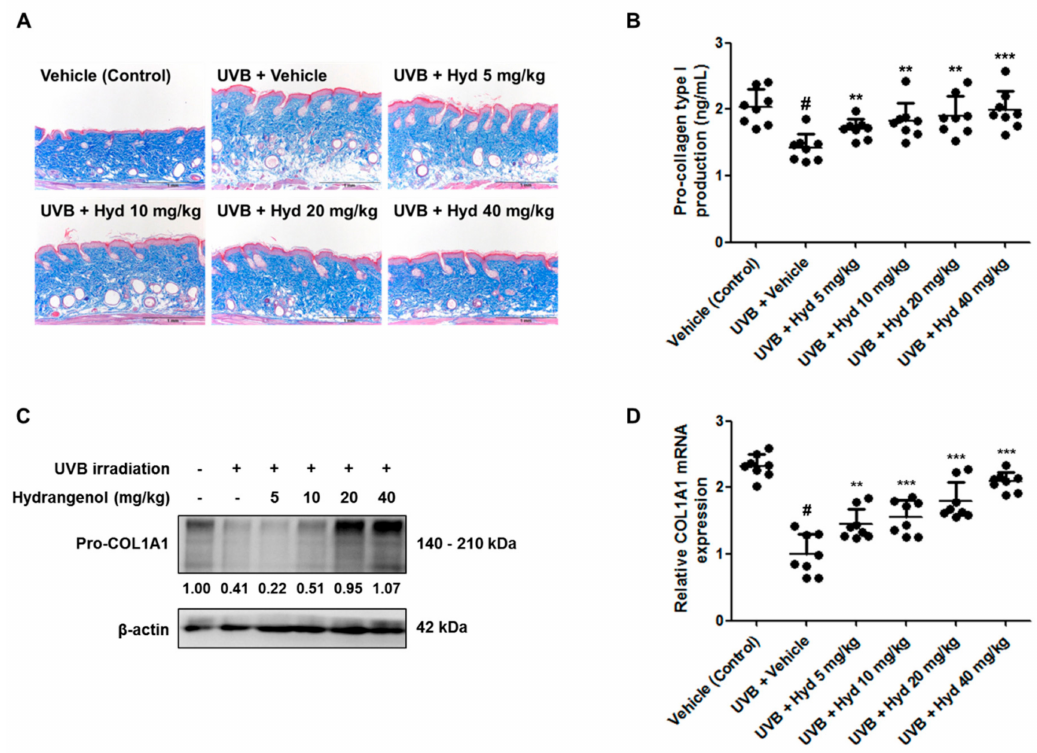
Figure 5. E ff ects of oral administration of hydrangenol on collagen content in UVB-irradiated hairless mice. HR-1 hairless mice were administered hydrangenol (5, 10, 20, or 40 mg / kg) daily for 7 weeks of exposure to UVB. ( A ) Skin tissues were subjected to Masson’s trichrome staining to observe collagen fibers of each group of mice. Total proteins and RNA were extracted from dorsal skin tissues. The protein lysates were used to measure ( B ) procollagen type 1 production. ( C ) The protein expression of Pro-COL1A1 was estimated by Western blotting using a specific Pro-COL1A1 antibody. The internal control was a β -actin protein. Each band is representative of three experiments. ( D ) COL1A1 mRNA levels were analyzed by qRT-PCR. Values are expressed as means ± SD ( n = 8). # p < 0.05 vs. the vehicle-treated control group; ** p < 0.01, and *** p < 0.001 as compared to the UVB + vehicle-treated